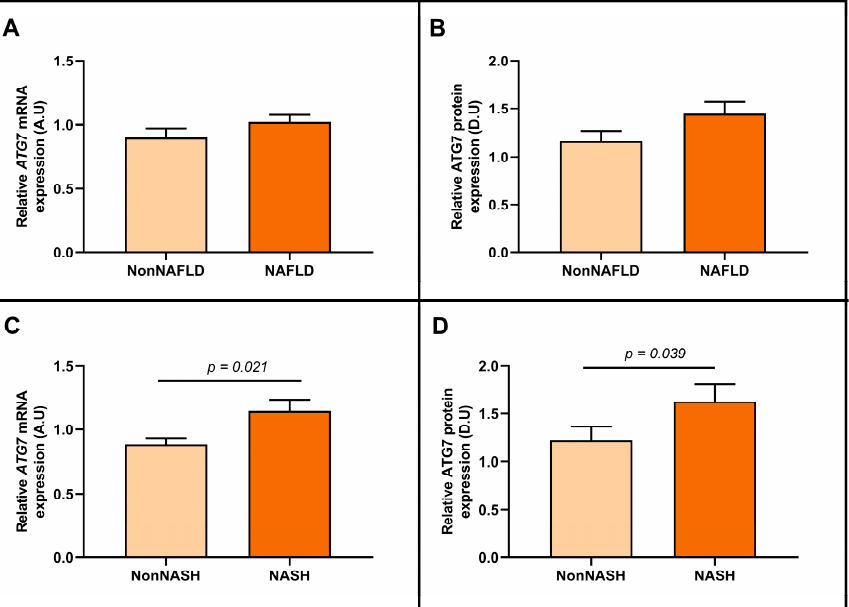
Figure 3. Differential relative ATG7 mRNA ( A ) and ATG7 protein ( B ) abundance in hepatic tissue between women classified according to the presence or the absence of NAFLD. Differential relative ATG7 mRNA ( C ) and ATG7 protein ( D ) abundance between women classified according to the presence or the absence of NASH. mRNA expression analysis: non-NAFLD ( n = 17), NAFLD ( n = 61), non-NASH ( n = 46), and NASH ( n = 32); and protein expression analysis: non-NAFLD ( n = 10), NAFLD ( n = 11), non-NASH ( n = 15), and NASH ( n = 6). ATG7/ATG7, autophagy-related 7 gene/protein; NAFLD, metabolic associated fatty liver disease; NASH, nonalcoholic steatohepatitis; A.U arbitrary units; D.U, densitometry units. Differences between groups were calculated using the Mann–Whitney test and p < 0.05 was considered statistically significant.